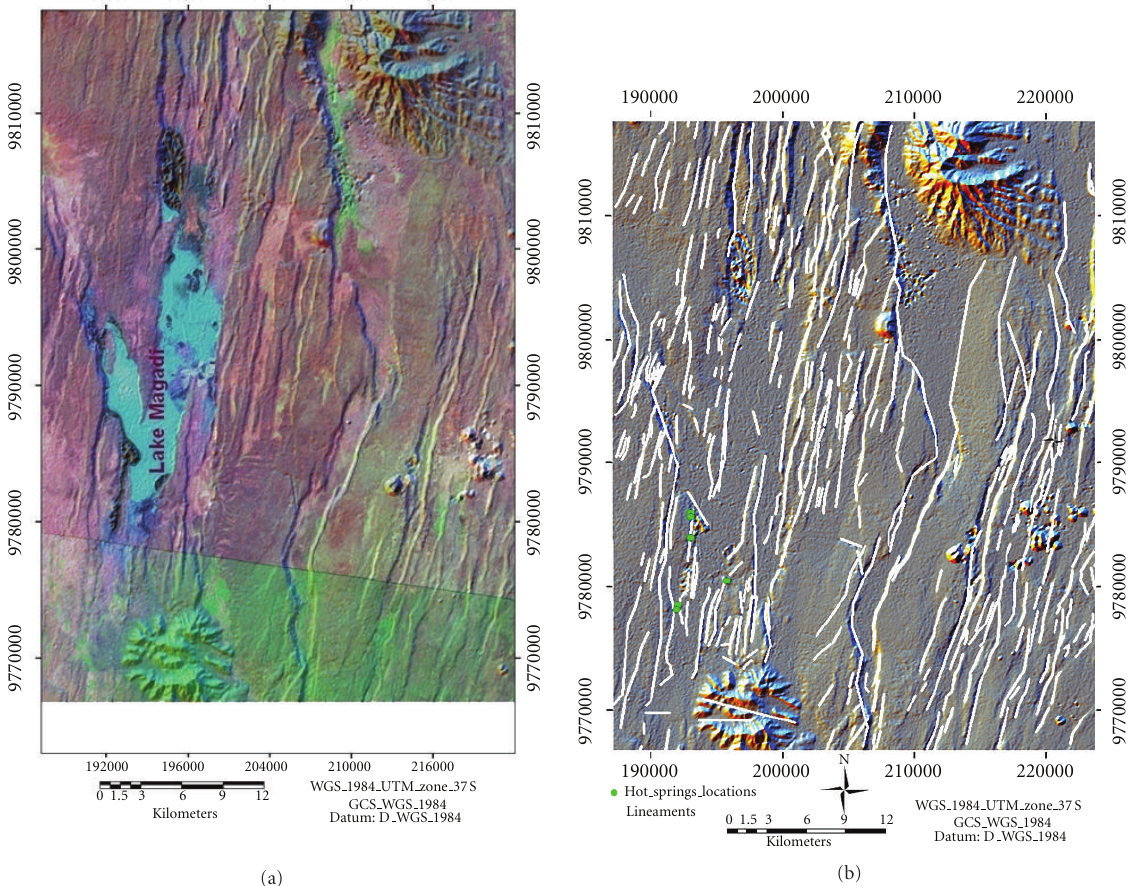
Figure 4: (a) Shaded relief ASTER DEM Image (30m resolution) draped over by ASTER bands 7-3-1. The images show the structural trend of Lake Magadi. (b) Extracted lineaments from remote sensing data overlaid on Aster